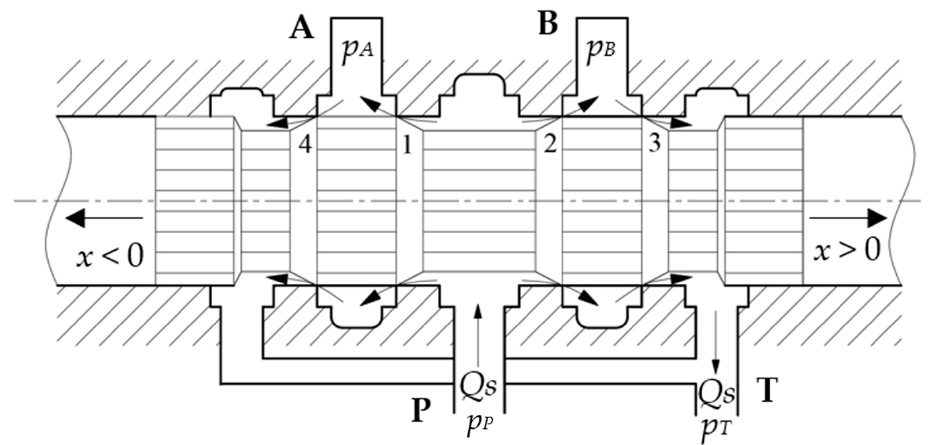
Figure 1. Flow analysis through the spool valve in center position x = 0.